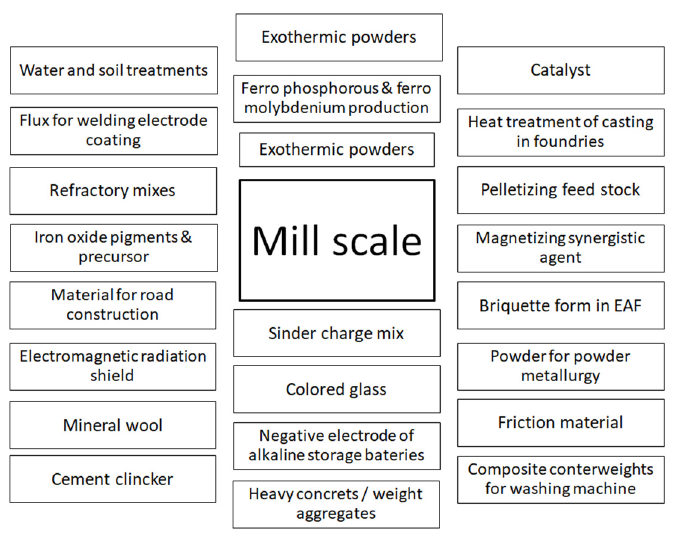
Figure 1. Different uses of mill scale [19] .